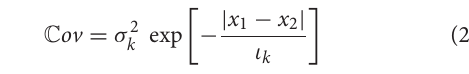
Frontiers in Environmental Science |